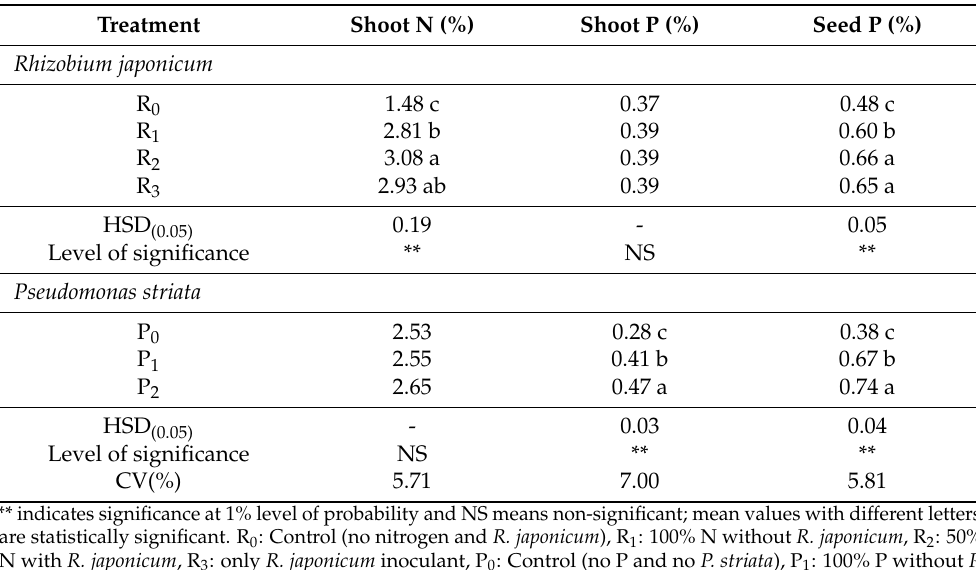
Table 6. Effect of Rhizobium japonicum and Pseudomonas striata on nitrogen and phosphorus content of soybean shoot and seed at harvest.